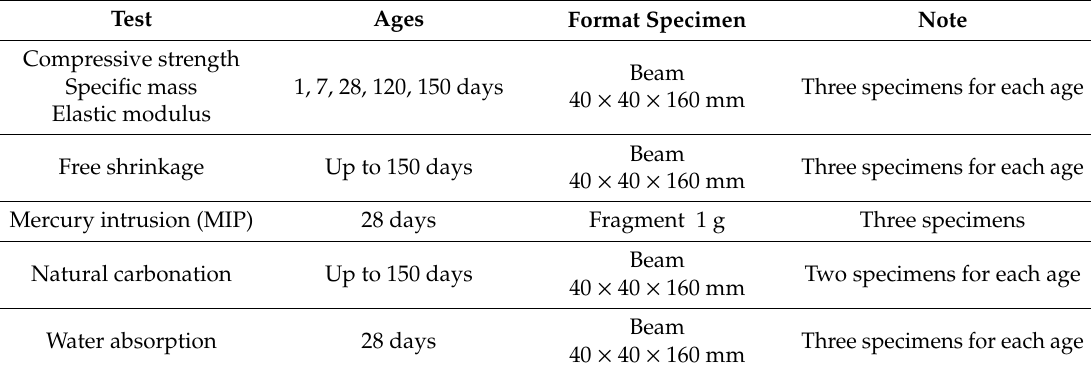
Table 3. Specimens manufactured for each mortar.